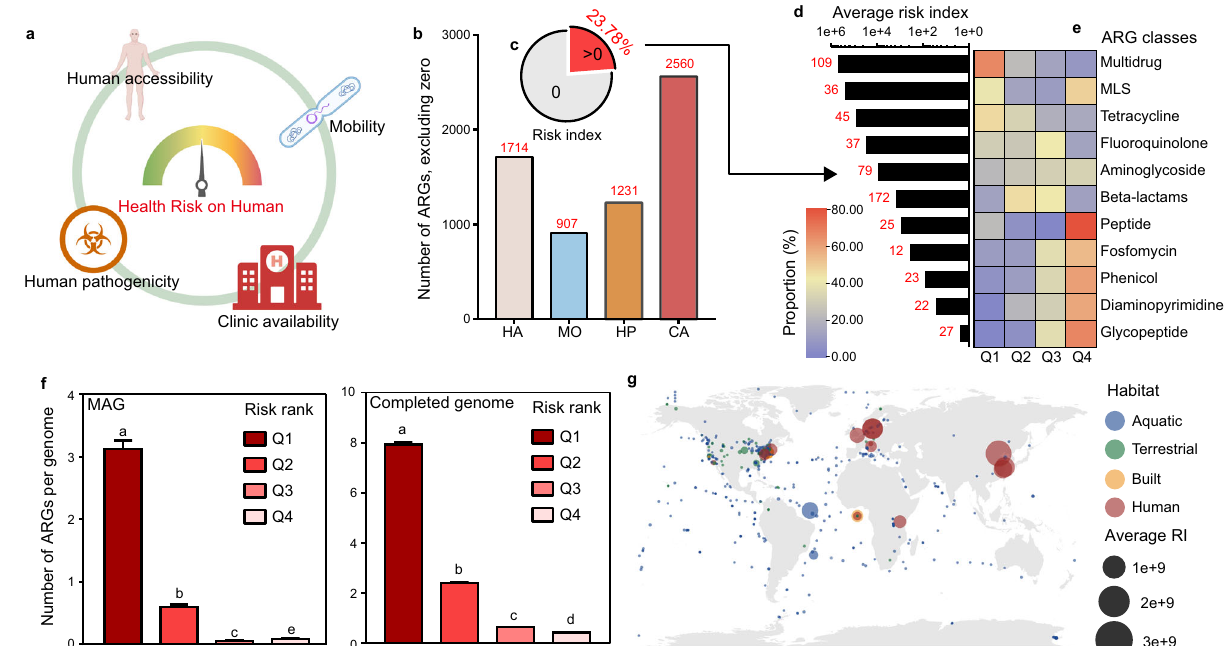
Fig. 3 Health risk evaluation of ARGs. a We evaluated the health risk of human for each ARG with four indicators, including human accessibility (HA), mobility (MO), human pathogenicity (HP), and clinical availability (CA). b Number of ARGs after excluding the zero value in each indicator for risk index calculation. c Only 23.78% of all evaluated ARGs exhibited risk index (RI) > 0. RI of most ARGs was zero because of the strict formula we used. d The number and average RI of ARGs in each class. Only classes that had more than 10 ARGs with RI > 0 were shown. Most of the ARGs with RI > 0 were referred to multidrug resistance with the highest average RI. e Composition of ARGs with RI > 0 in different classes. Most of the ARGs which resisted commonly used antibiotics belonged to Q1, while most of ARGs which resist rarely used antibiotics belonged to Q4. f Number of ARGs per pathogenic genome, which assembled by hospital fecal metagenomes ( n = 568 MAGs) or from the completed genome dataset ( n = 15,596 MAGs). Pathogens carried much more ARGs belonged to the Q1, compared with other ranks. Different letters represented the signi fi cant difference by Kruskal – Wallis H -test with the pairwise comparisons. Data were showed as mean ± standard error of mean (SEM). g Global ARG risk map of four main habitats. Antibiotic resistance risk was detected all around the world, even in the polar region. Human-associated habitats posed the highest risk of antibiotic resistance than other habitats. The average RI of each sampling site was calculated by the combination of abundance and RI of ARGs and showed as the size of points. Habitats were showed as color. Samples with the unclassi fi ed location was showed as longitude = 0 and latitude =